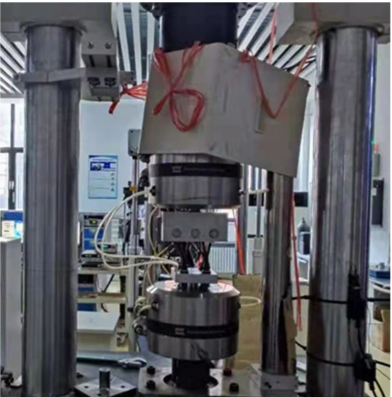
Figure 15. New bracket with the actual fatigue tester machine assembly diagram.